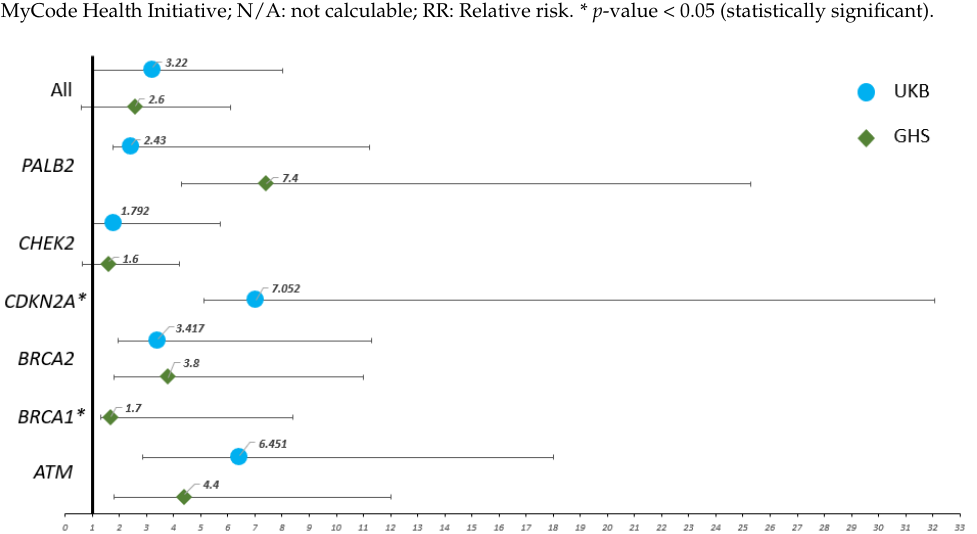
Figure 3. The relative risk of pancreatic ductal adenocarcinoma in participants harboring germline pathogenic variants for each gene. PDAC: pancreatic ductal adenocarcinoma, GPV: germline pathogenic variant. UKB: UK Biobank; GHS: Geisinger MyCode Health Initiative. * Variants identified only in one cohort.